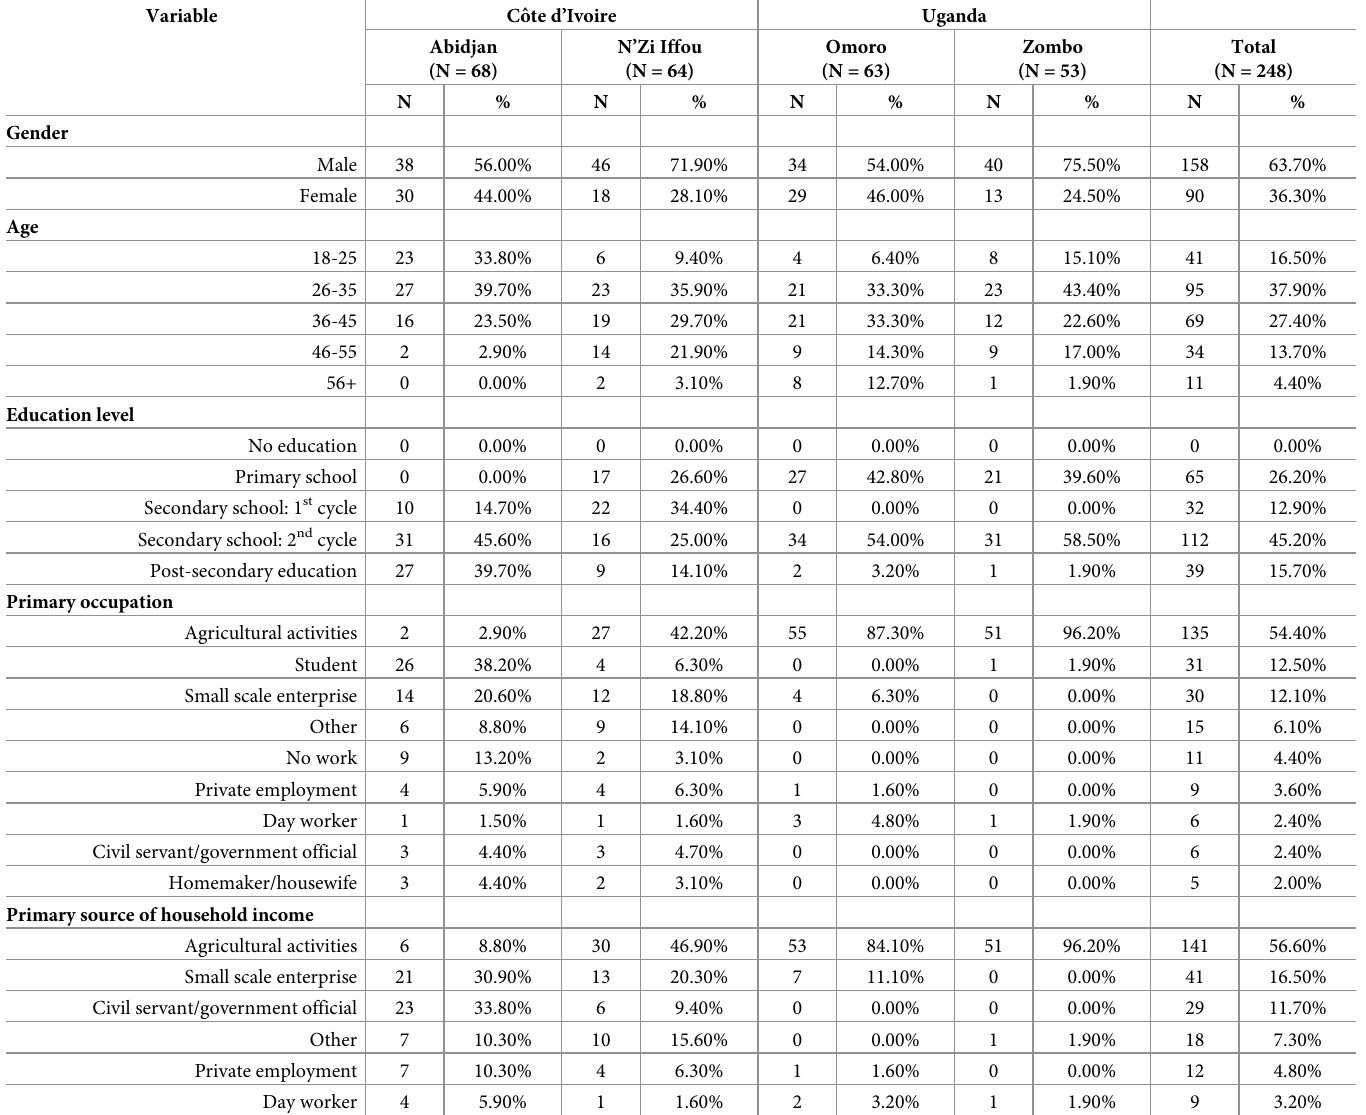
Table 2. Demographics of surveyed community drug distributors (CDDs), by region/district. Variable